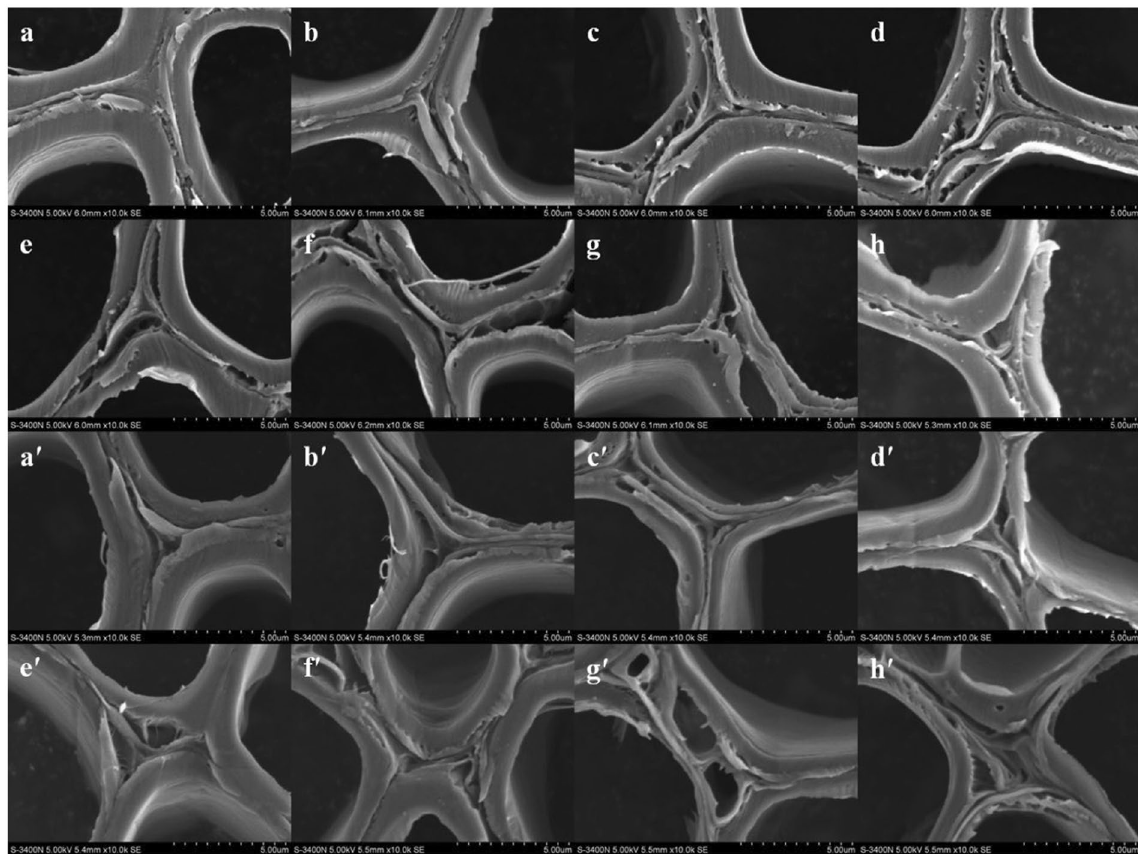
Figure 4. SEM images of the Eucalyptus cell walls at magnification × 10000: untreated ( a ), hydrothermally pretreated (at 150, 160, 170, 180, 190, 200, and 210 °C for 0.5 h, b – h ), untreated and hydrothermally pretreated followed with 2% NaOH at 80 °C for 2 h ( a ′ – h ′